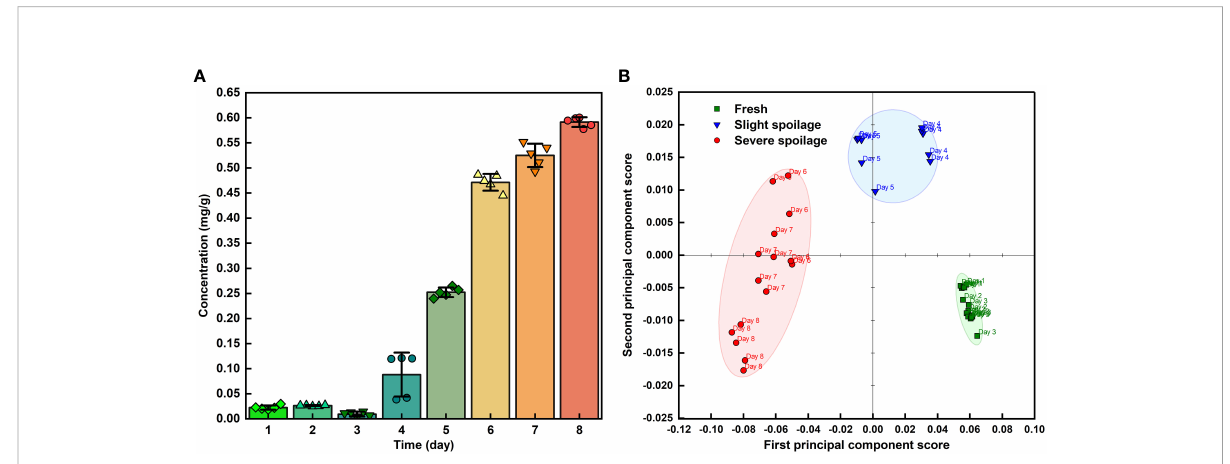
FIGURE 6 (A) The ethanol concentration in volatiles released from grapes during storage; (B) PCA analysis of 40 infrared spectra of grape volatiles corresponding to different storage times.